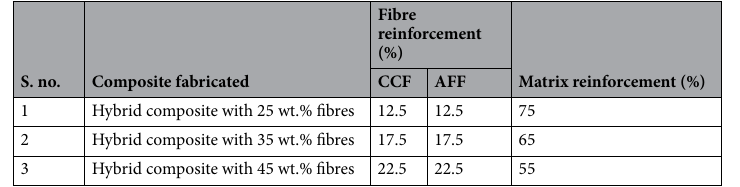
Table 1. Details of fabricated